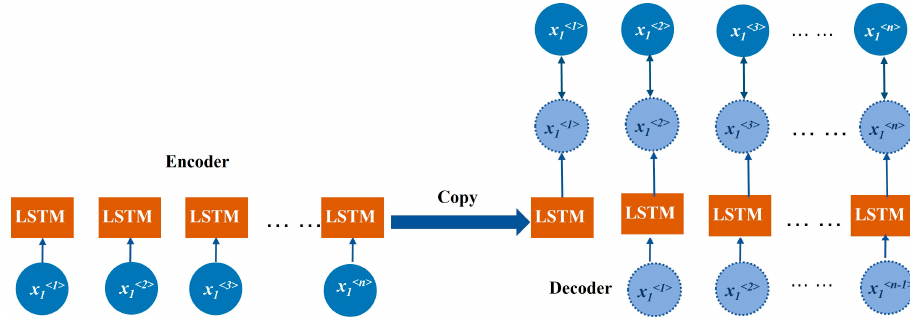
Figure 1. The architecture of